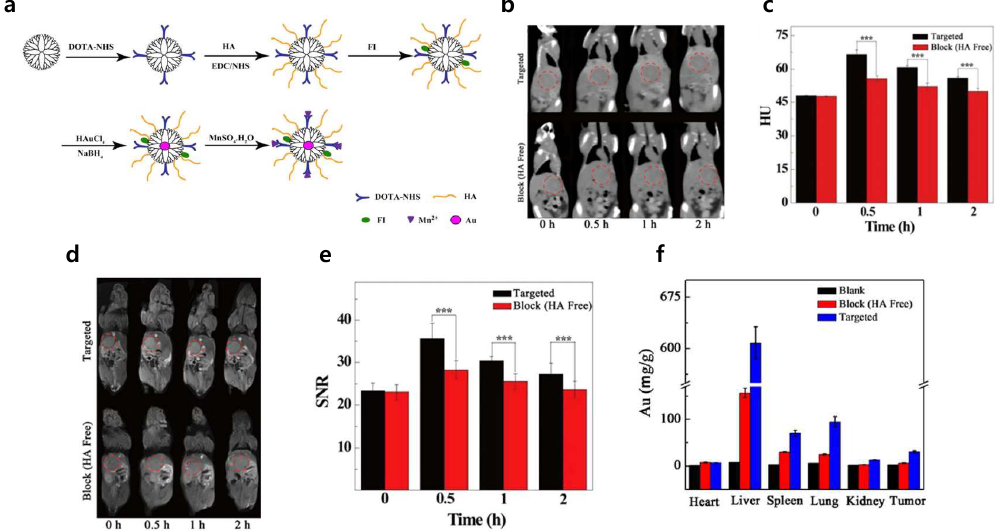
Figure 3. ( a ) Schematic diagram of the synthesis of {(Au 0 ) 100 G5.NH 2 -FI-DOTA(Mn)-HA} nanoparticles (NPs). ( b ) In vivo CT images and ( c ) CT values (Hounsfield units, HU) of orthotopic liver tumors at di ff erent times after a 0.3 mL intravenous injection of a {(Au 0 ) 100 G5.NH 2 -FI-DOTA(Mn)-HA} NP solution (0.3 mL in PBS, [Au] = 120 mM). ( d ) In vivo MR images and ( e ) signal-to-noise ratio (SNR) of orthotopic liver tumors at di ff erent times after an intravenous injection of 0.3 mL of a {(Au 0 ) 100 G5.NH 2 -FI-DOTA(Mn)-HA} NP (300 µ g Mn) solution in PBS. ( f ) Biodistribution in the major organs of the mice and tumors at 24 h after the intravenous injection of a PBS solution containing {(Au 0 ) 100 G5.NH 2 -FI-DOTA(Mn)-HA} NPs (0.3 mL in PBS, [Au] = 120 mM). Reproduced